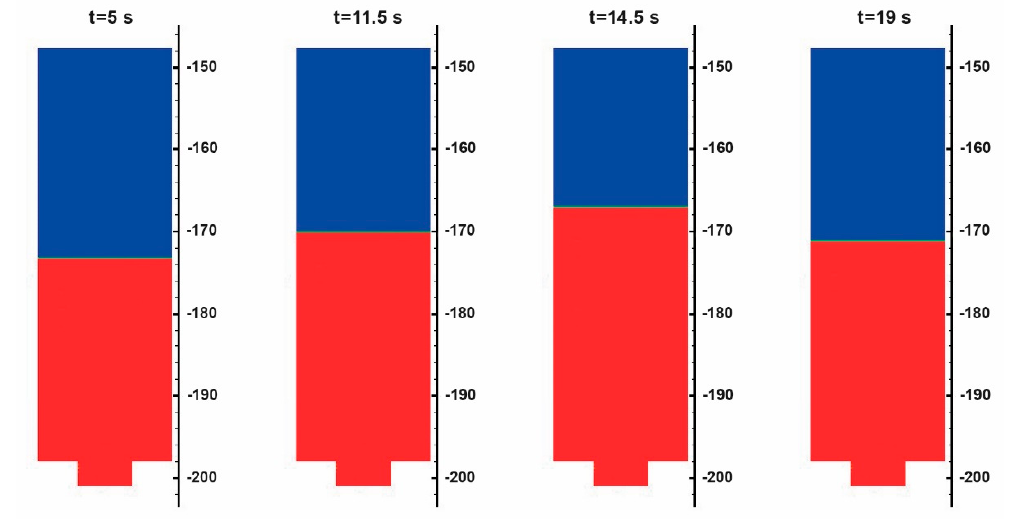
Figure 8. Water level fluctuation in the closed surge tank. Guide vanes closure time of 1 s.